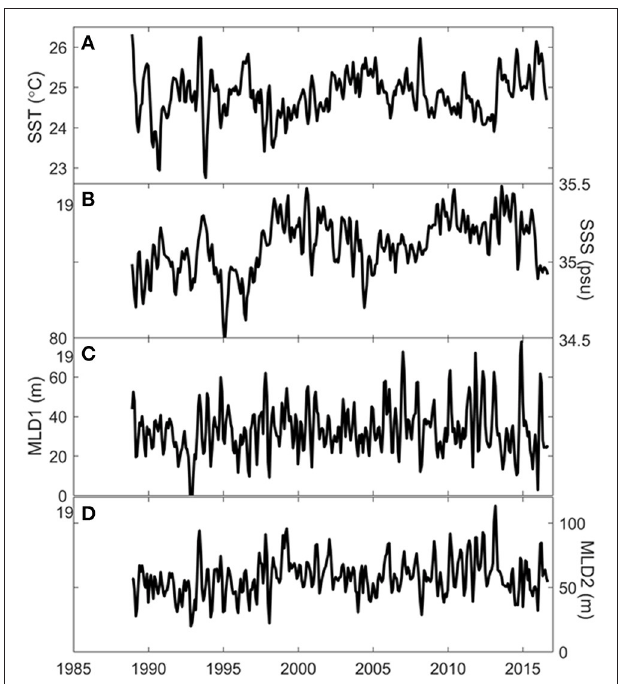
FIGURE 6 | In situ surface conditions at Station ALOHA showing anomalies for (A) sea surface temperature (SST); (B) sea surface salinity; (C) mixed layer depth as defined by a vertical gradient threshold of 0.005kg m − 3 m − 1 for potential density and (D) mixed layer depth as defined by a density surface offset of 0.125kg m − 3 .